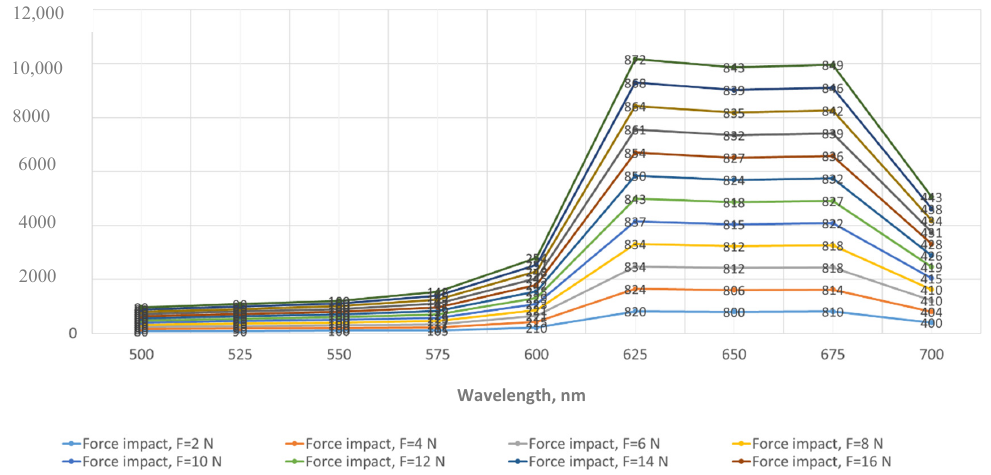
Figure 13. Nomographic chart of fluorescence spectra of the damaged potato tubers at wavelengths of 600, 650, and 700 nm